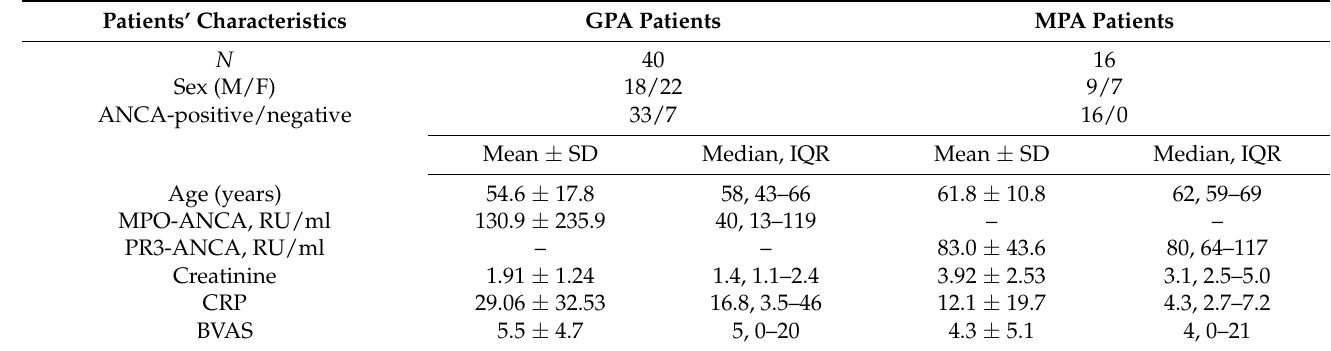
Table 1. The patients’ clinical